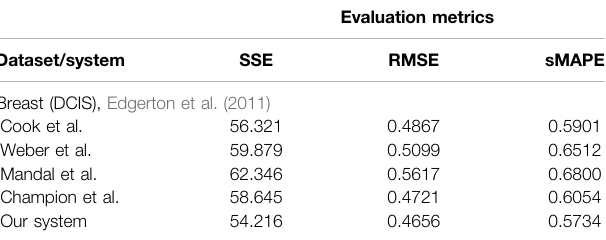
TABLE 3 | Evaluation of the data-driven relation learning systems.